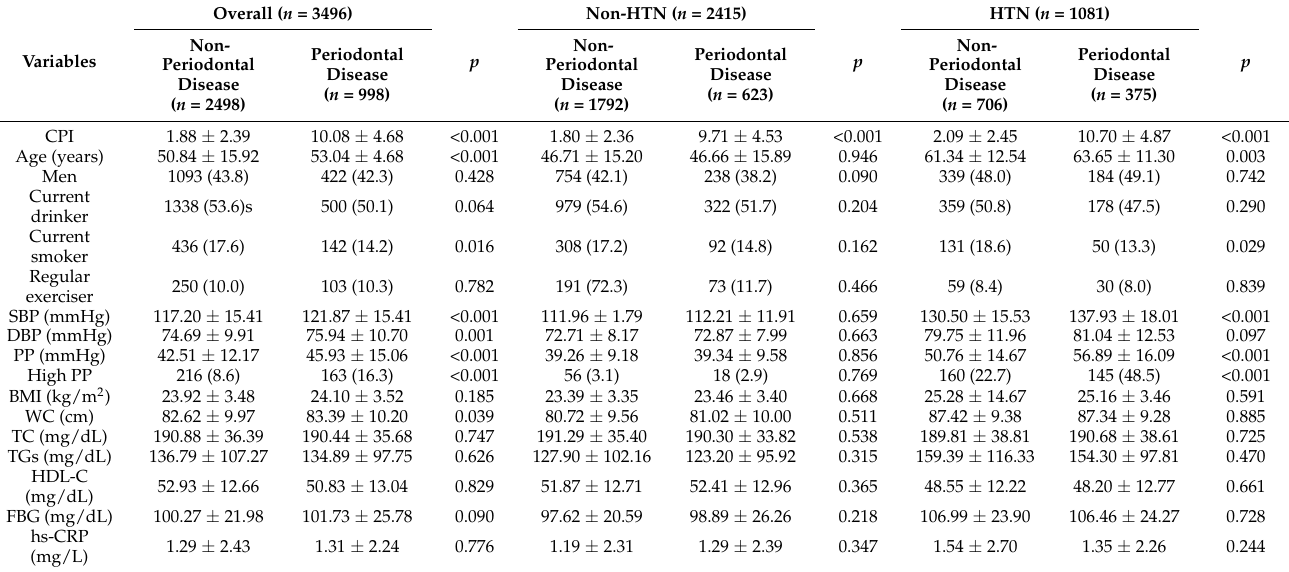
Table 2. General clinical characteristics according to periodontal disease in overall, non-HTN, and HTN groups.